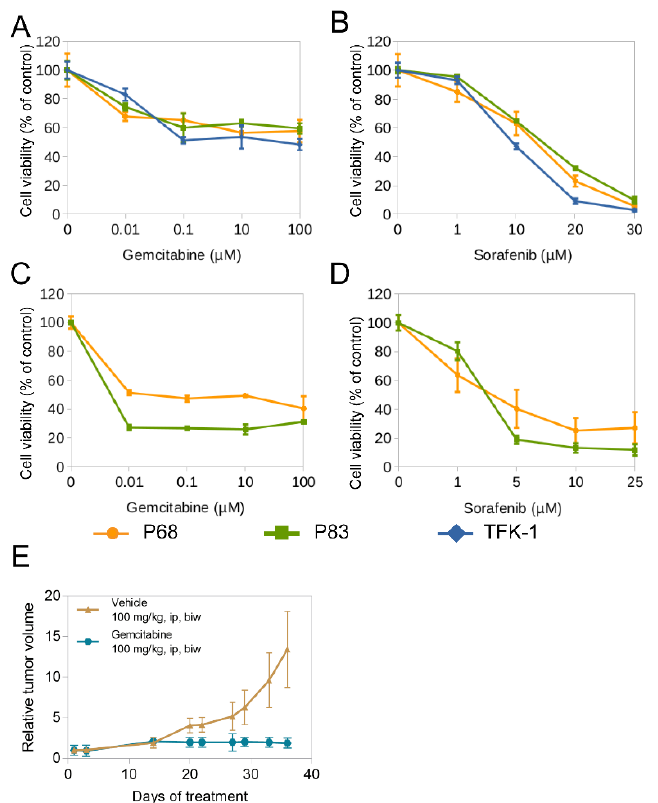
Figure 6. Treatment of PDOs and CCLs. Top row: Dose-response of 2D cell lines treated with ( A ) Gemcitabine; ( B) Sorafenib; Middle row: Dose-response of organoids with ( C ) Gemcitabine; ( D ) Sorafenib; Bottom: ( E ) Subcutaneous PDO-derived xenografts treated with gemcitabine (100 mg/kg body weight i.p. biw) or glucose solution as control vehicle ( n = 5 each). Tumor volume was calculated using the following formula: V = (width 2 × length)/2 and normalized to day 1 of treatment. All experiments were performed in triplicates unless indicated otherwise. Abbreviations: ip, intraperitoneal injection; biw, twice weekly.